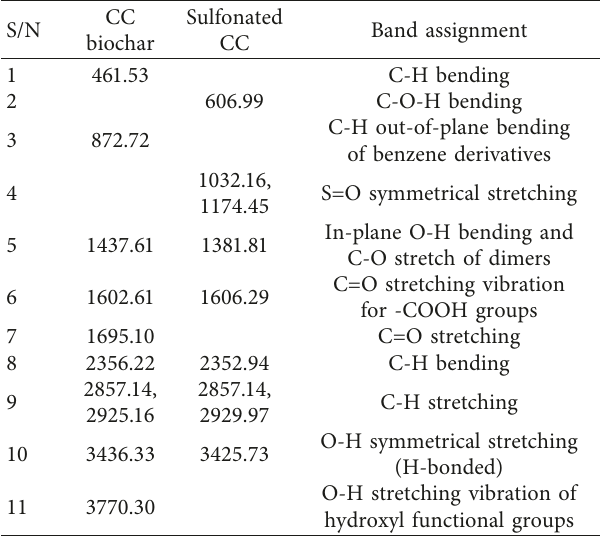
Table 2: Analysis of FT-IR spectra of the raw and activated biochar from corn cob.